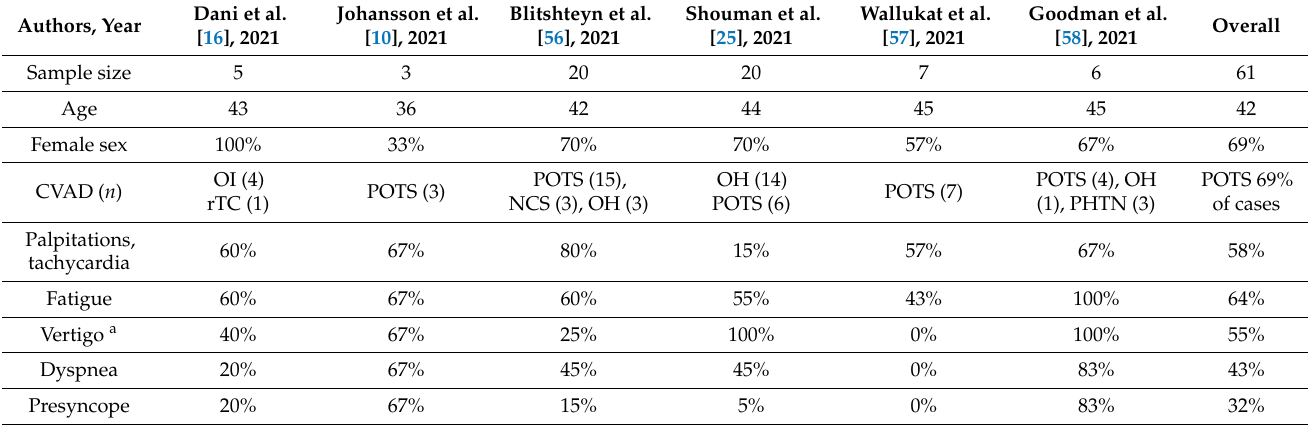
Table 2. Case series of patients diagnosed with CVAD following